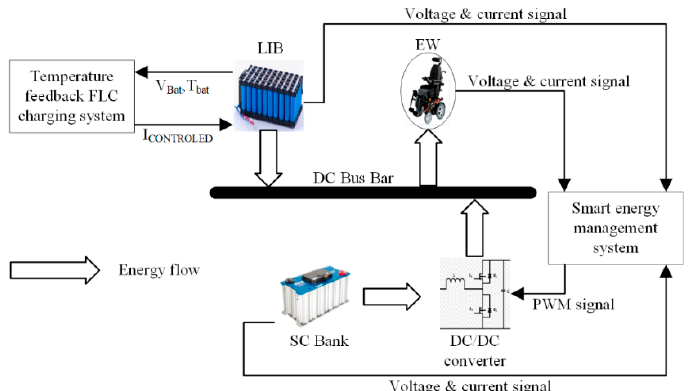
Figure 2. Overview of the proposed methodology. Battery voltage (V Bat ), controlled current (I controlled ), battery temperature (T bat ), lithium-ion battery (LIB), electric wheelchair (EW), pulse width modulation (PWM) and supercapacitor (SC).